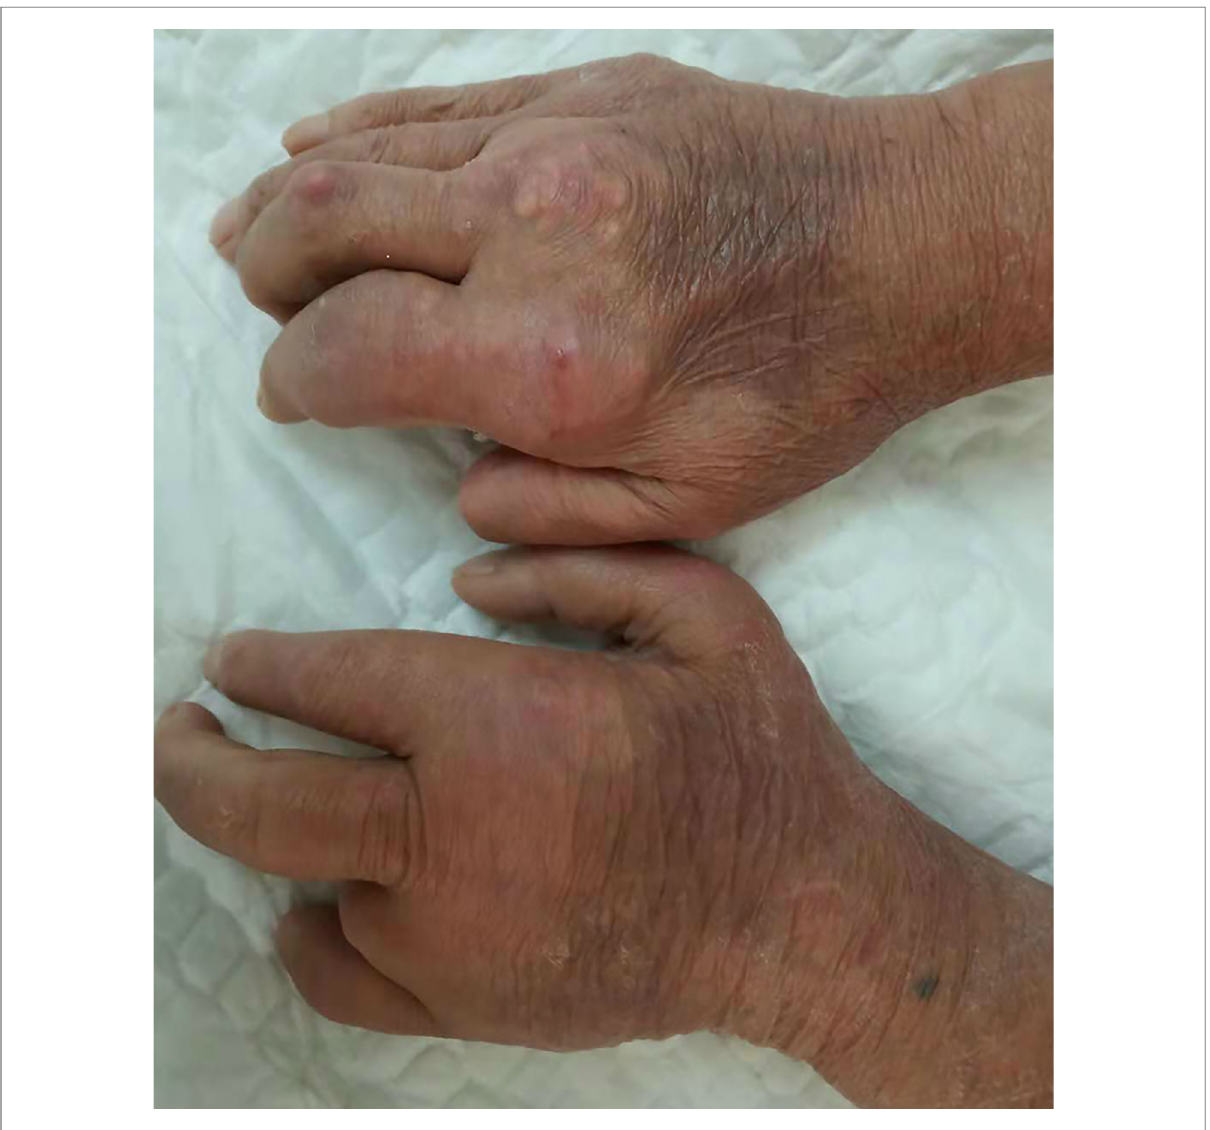
FIGURE 1 Preoperative examination showing that gout nodules of different sizes could be touched in both